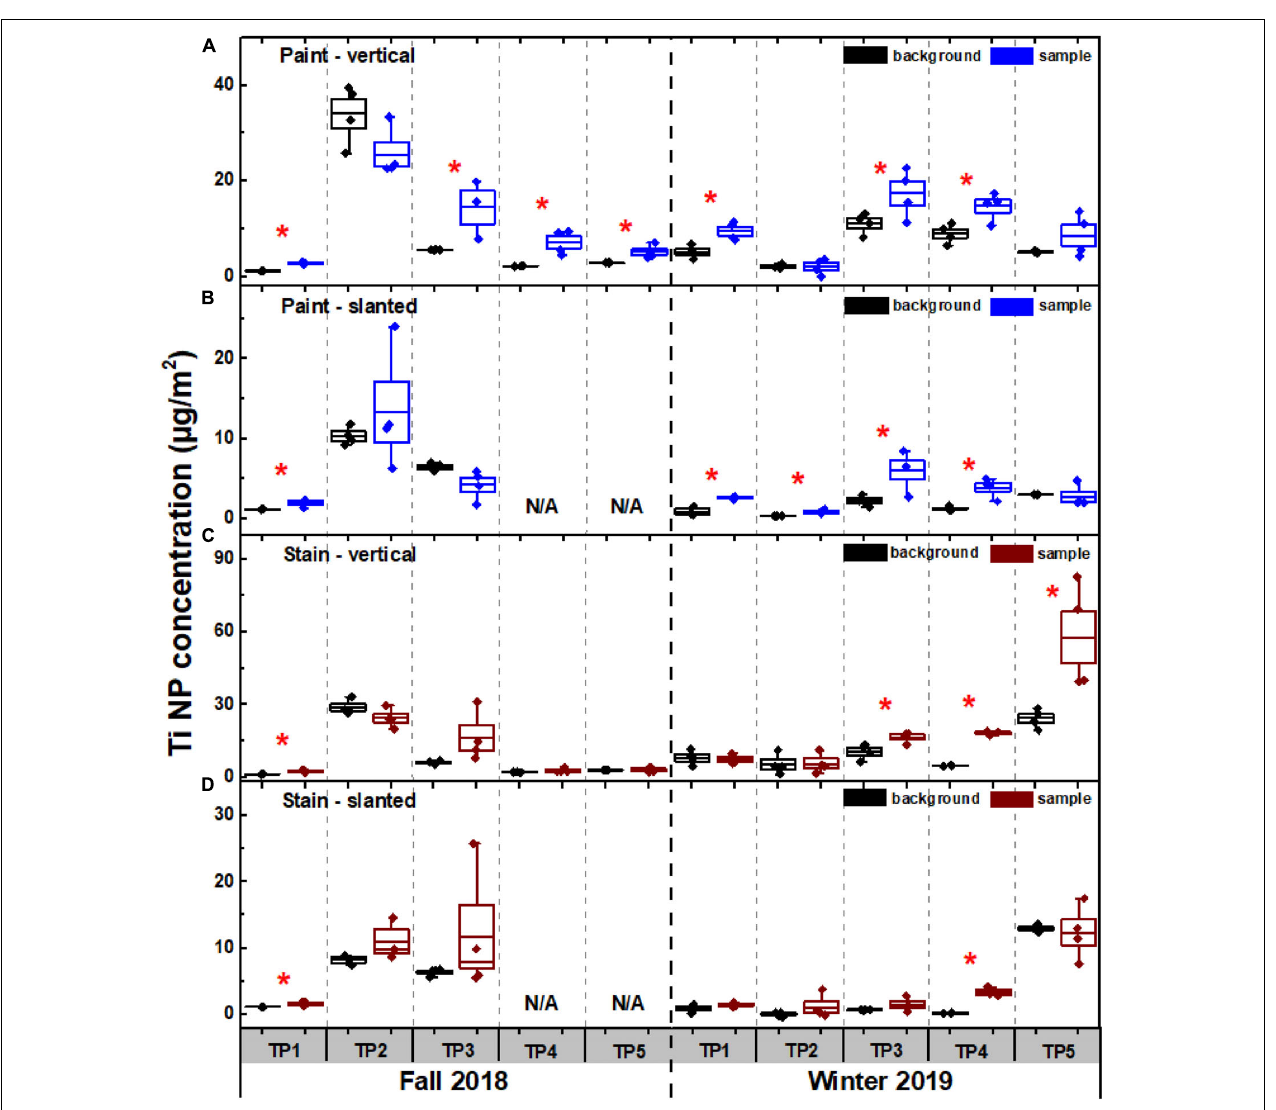
FIGURE 2 | Quantification of Ti containing NPs in the precipitation (i.e. background) and in the precipitation following its contact with (A,B) painted and (C,D) stained panels. Weathering experiments were conducted using two exposure designs ( Figure 1 ), (A,C) vertical and (B,D) slanted, for painted and stained panels. A red star indicates a significant difference ( N = 4, student t -test, p < 0.05) between the NP content in the background and the NP content in the sample. NP concentrations were normalized by the surface area of the painted/stained panels subjected to weathering. Containers were renewed at each timepoint (TP). Measurements were performed using a magnetic sector ICP-MS in single particle mode. Measured NP content includes particles between the instrumental size detection limit of ∼ 15 nm and the filtration cut-off (0.45 µ m). N/A denotes two samples that were lost.